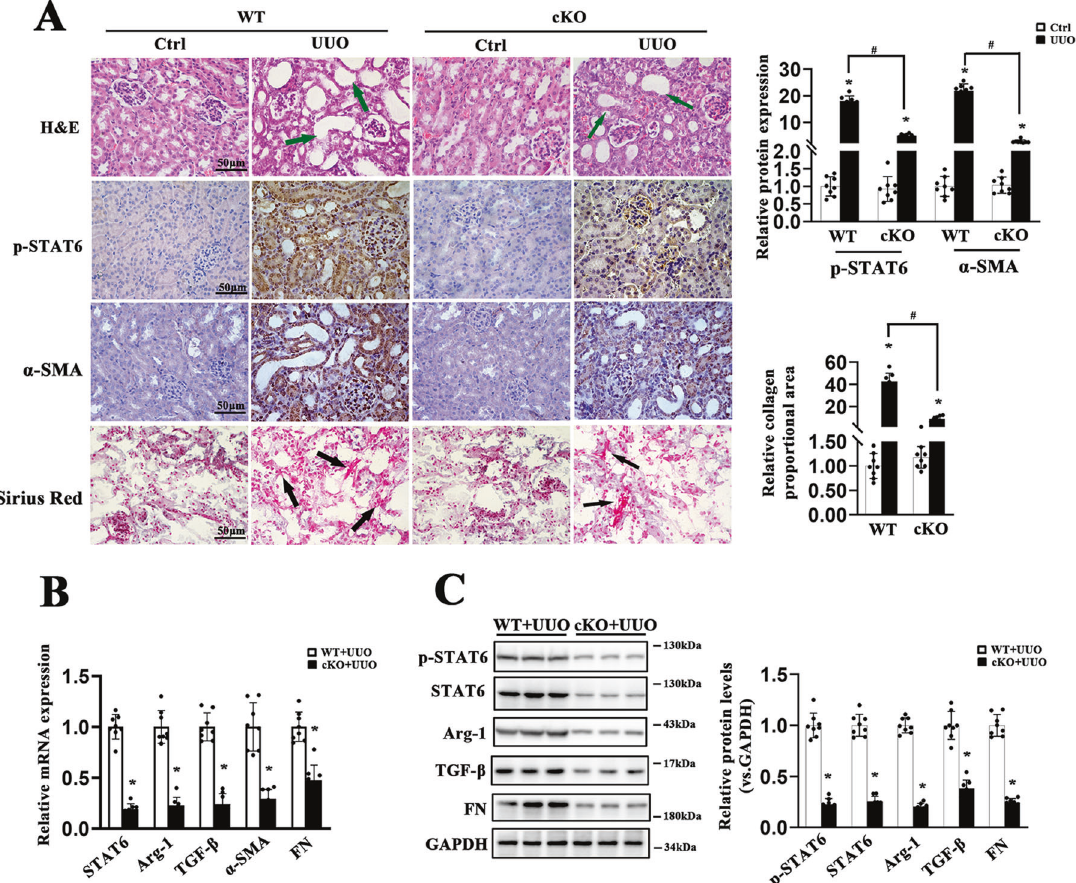
Fig. 2 STAT6 de fi ciency in tubular cells attenuates UUO-caused renal fi brosis. The tubular-speci fi c-Stat6 KO and control littermates were sacri fi ced 1w after UUO operation. A Representative IHC staining of p-STAT6, α -SMA, and micrographs for H&E, Sirius red staining in the control and fi brotic kidneys from the indicated group and quanti fi cation was performed. B The mRNA and C protein expression of p-STAT6, STAT6, Arg-1, TGF- β , α -SMA, FN in the indicated treatments were determined by qRT-PCR or immunoblot analyses with the quanti fi cation on the right panel. Results are expressed as the mean ± SD ( n = 8, * p < 0.05, Stat6 WT vs . Stat6